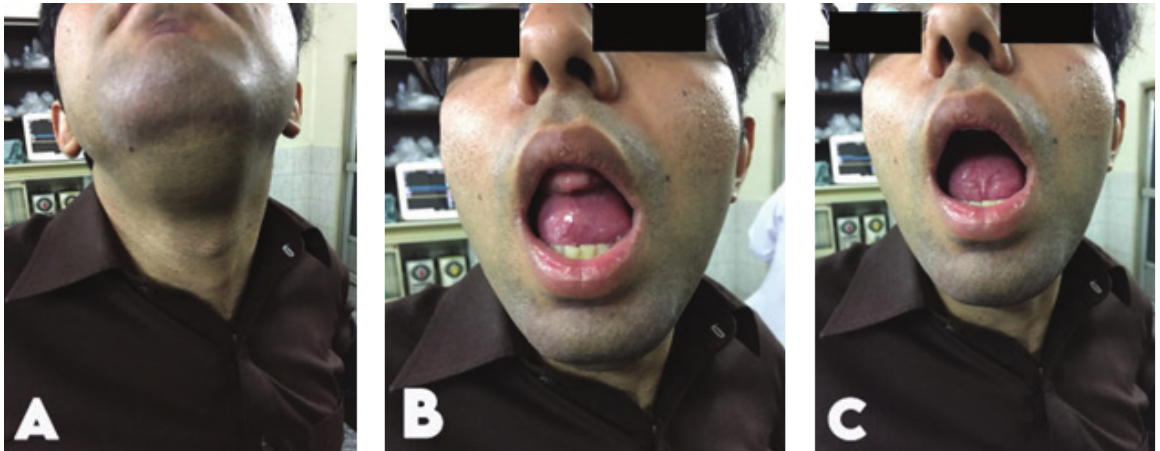
Figure-I: (A) Extra-Oral frontal view of the giant dermoid cyst, (B) Intra-oral view of cyst indicating Double tongue, second tongue appearance, (C) Intraoral view with the tongue touching the roof of the palate.